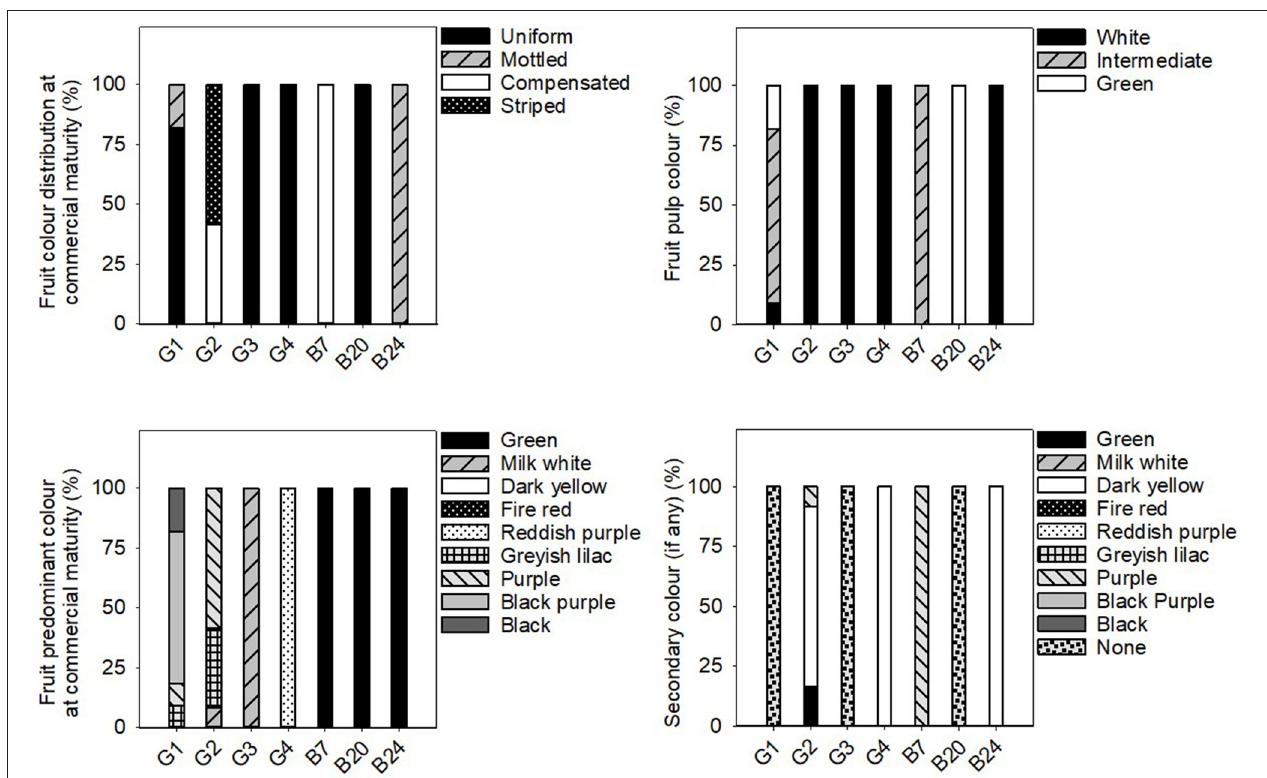
FIGURE 5 | Frequency distribution (%) of the fruit qualitative traits related to fruit colour in the 31 eggplant landraces in each group (G1, G2, G3, G4) and B7, B20, and B24. Measurements were taken when fruits reached the commercial maturity. Data for fruit traits were measured from 10 different fruits which were representative of the landrace.